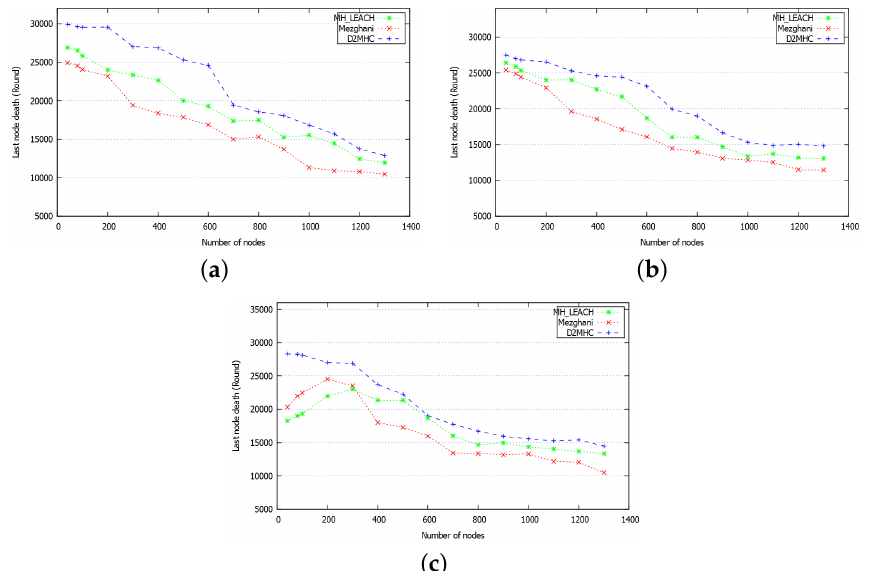
Figure 16. Last node death according to different nodes density with ( a ) k = 1, ( b ) k = 2, ( c ) k = 3.